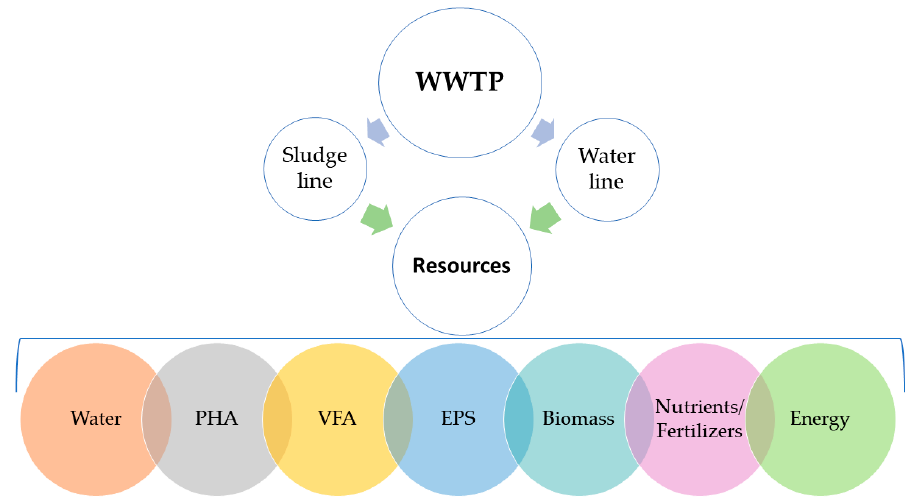
Figure 1. General overview of the review article: from wastewater to resource.